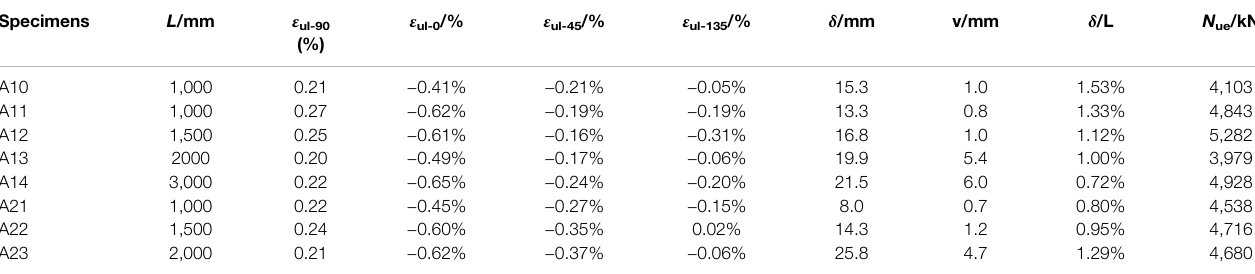
TABLE 4 | Results of column tests.